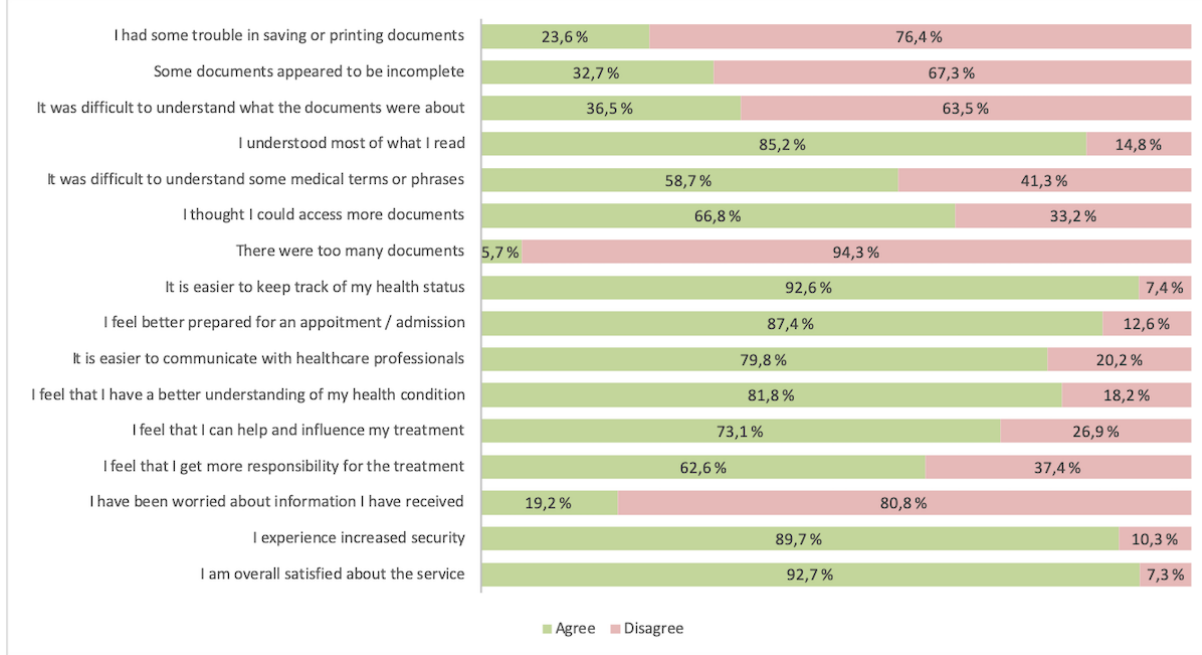
Figure 2. Patient satisfaction with online access to electronic health